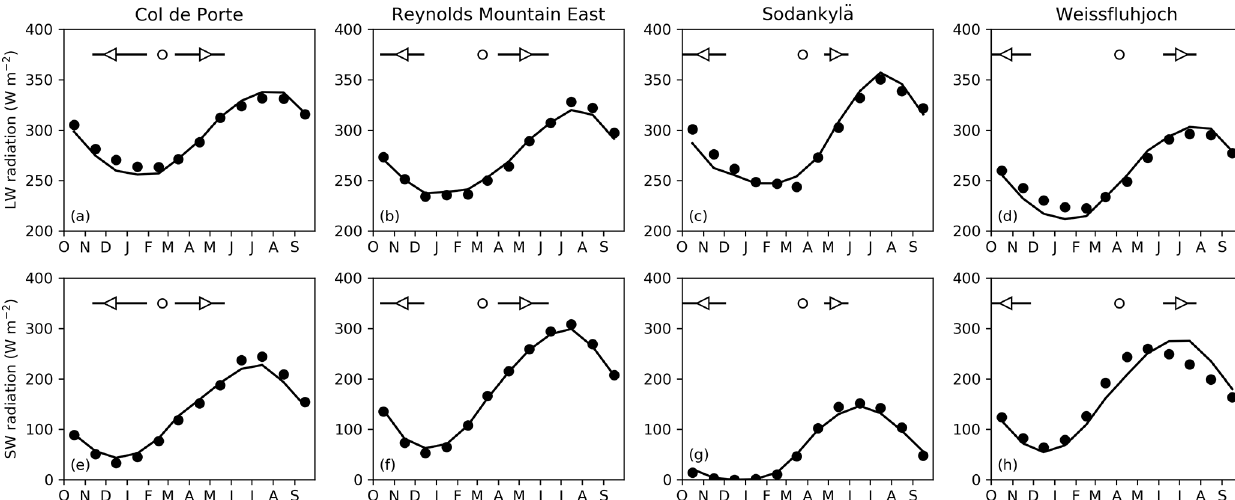
Figure 2. Monthly means of (a–d) incoming longwave radiation and (e–h) incoming shortwave radiation from measurements at the sites (filled circles) and the driving data (lines). Horizontal bars show ranges of observed start and end dates of continuous seasonal snow cover as in Fig. 1.